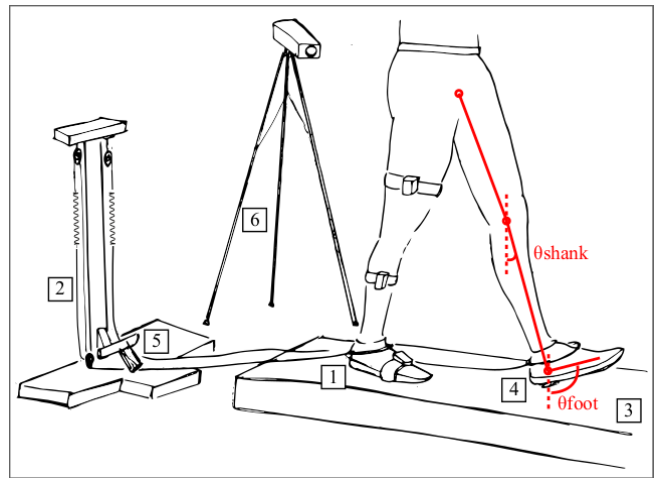
Figure 1. Schematic of the experimental setup. Labeled components are as follows: 1. perturbed foot; 2. spring-rope mechanism; 3. treadmill; 4. footswitch under the unperturbed foot; 5. cam-based braking mechanism; 6. camera-based motion capture system. As a representative example, the position of the Inertial Measurement Units (IMUs) is reported on the thigh, shank and foot of the right limb, and the elevation angles used as input of the algorithm (i.e., elevation angles of the shank and foot —θshank and θfoot , respectively) are depicted on the left limb.